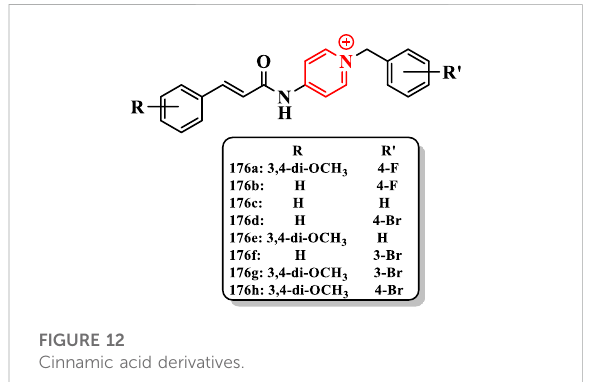
FIGURE 12 Cinnamic acid